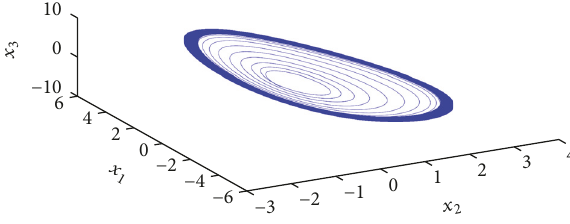
Figure 2: The phase trajectory of system (46).